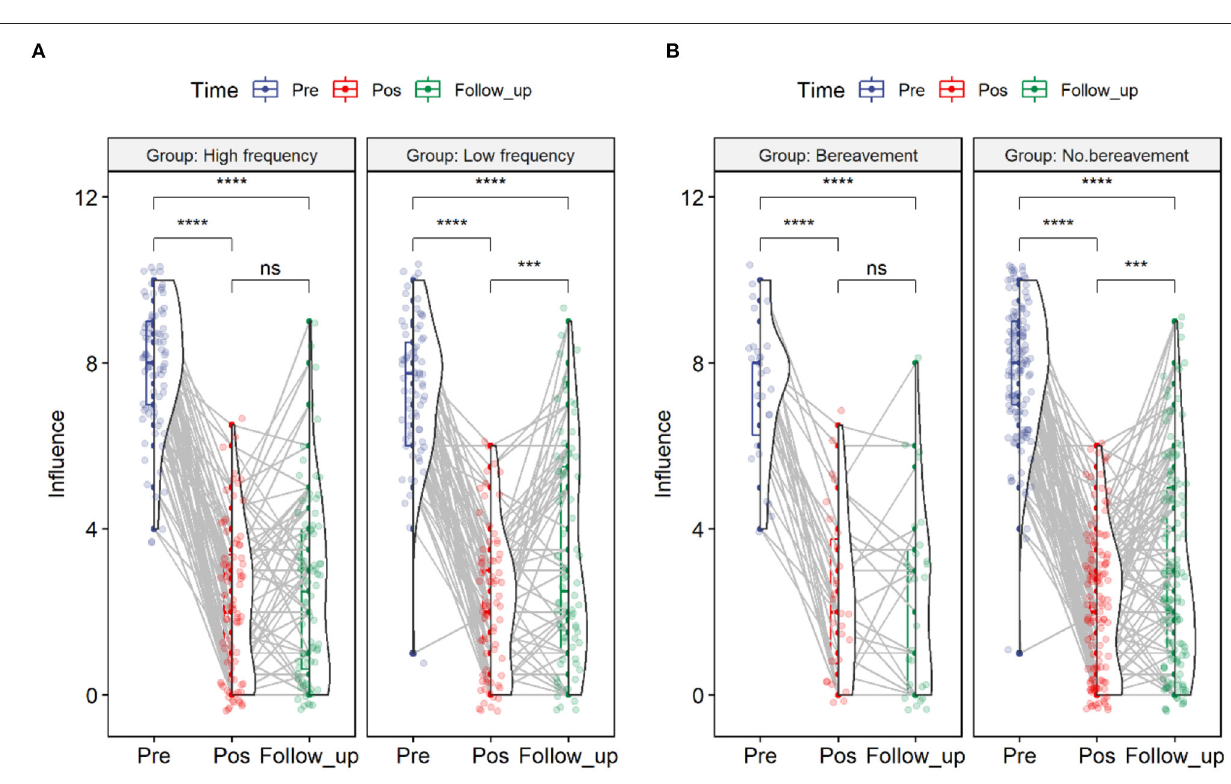
FIGURE 5 | The results of the mixed ANOVA analysis. (A) indicated the results of different degrees of frequency. (B) showed that whether bereavement or not could have a difference in